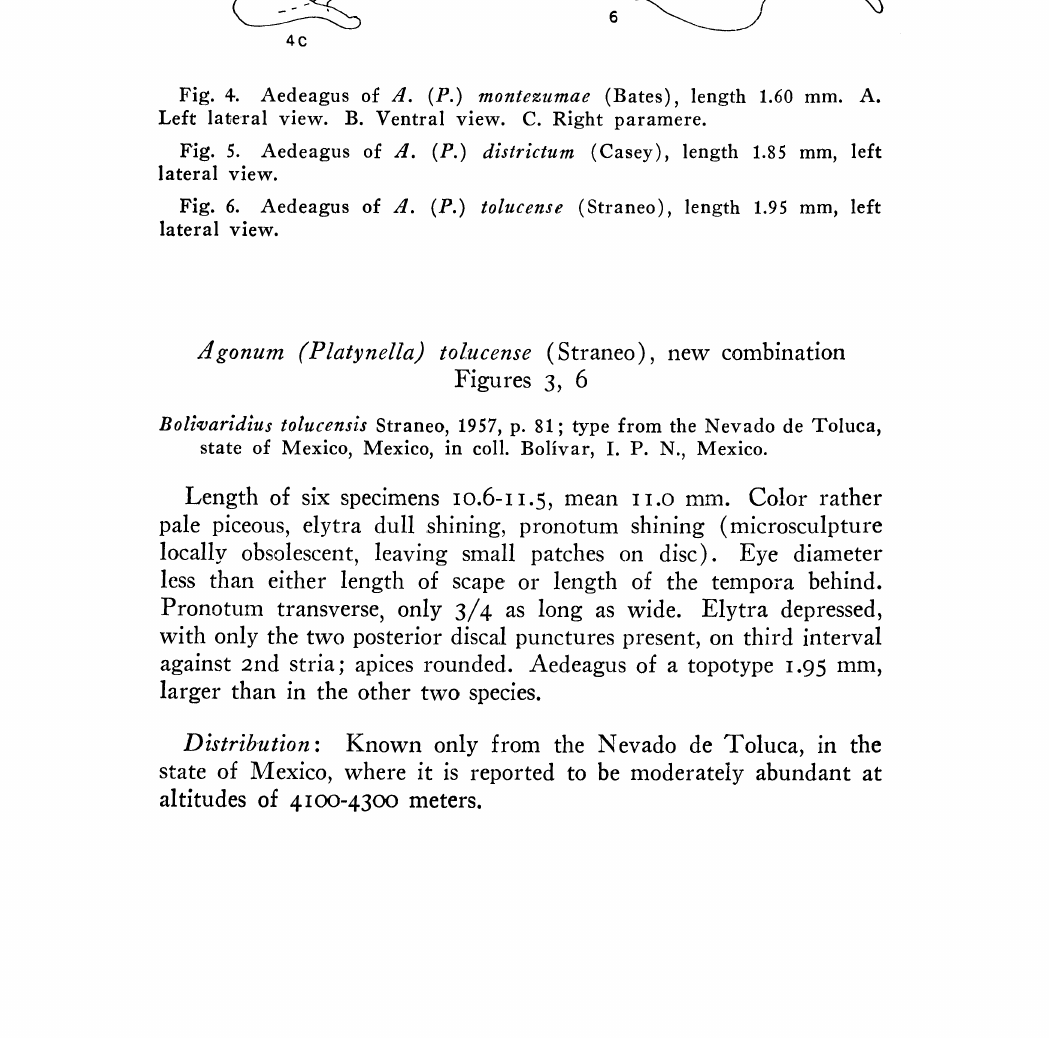
Fig. 4. Aedeagus of ‘4. (P.) montezumae (Bates), length 1.60 mm. A. Left lat, eral view. B. Ventral view. C. Right paramere. Fig. 5. Aedeagus of ‘4. (P.) districtum (Casey), length 1.85 mm, left lateral view. Fig. 6. Aedeagus of .4. (P.) tolucense (Straneo), length 1.95 mm, left lateral view.